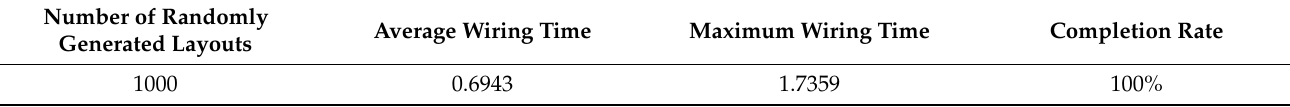
Table 3. Routing speed of three-dimensional line probe algorithm.